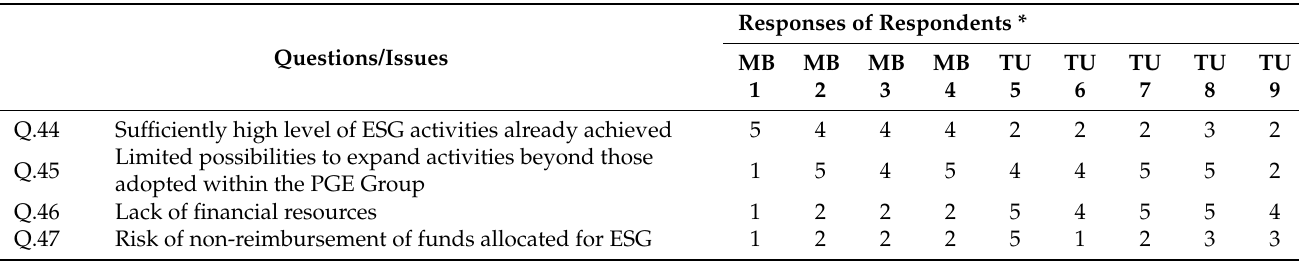
Table 4. Reasons for limiting (restricting) the Opole Power Plant’s ESG